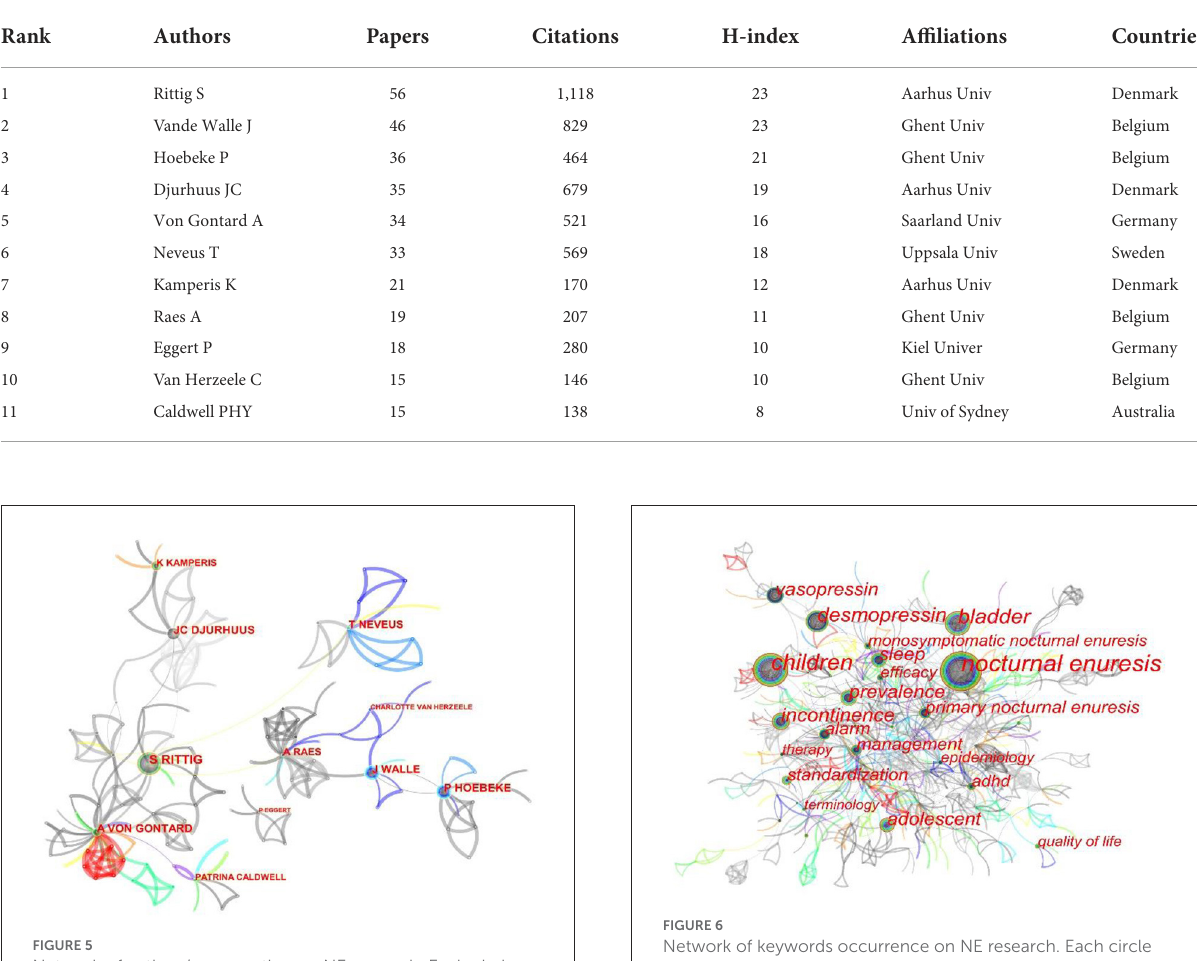
TABLE 4 The top 10 authors of publications volume on NE from 1982 to 2022.